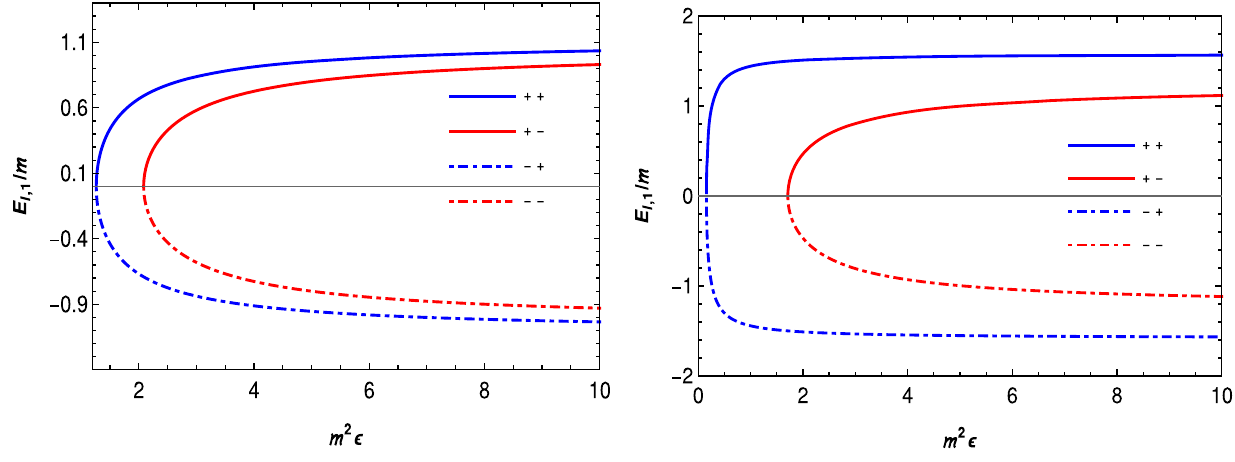
Fig. 1 In both graphs contained in the figures on the right and left, we | as a function of ω/ m . In the figure on the left, we have the have | E l , 1 m continuous blue curve that represents the positive sign inside the square root Eq. (18) and the red curve continues the negative sign also from